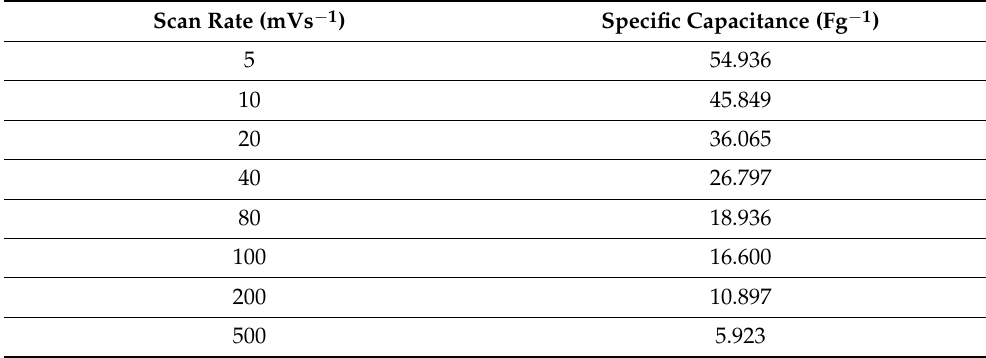
Figure 12. The CV profile for the fabricated EDLC cell at various scan rates. Table 3. Variation of specific capacitance at different scan rates for the fabricated